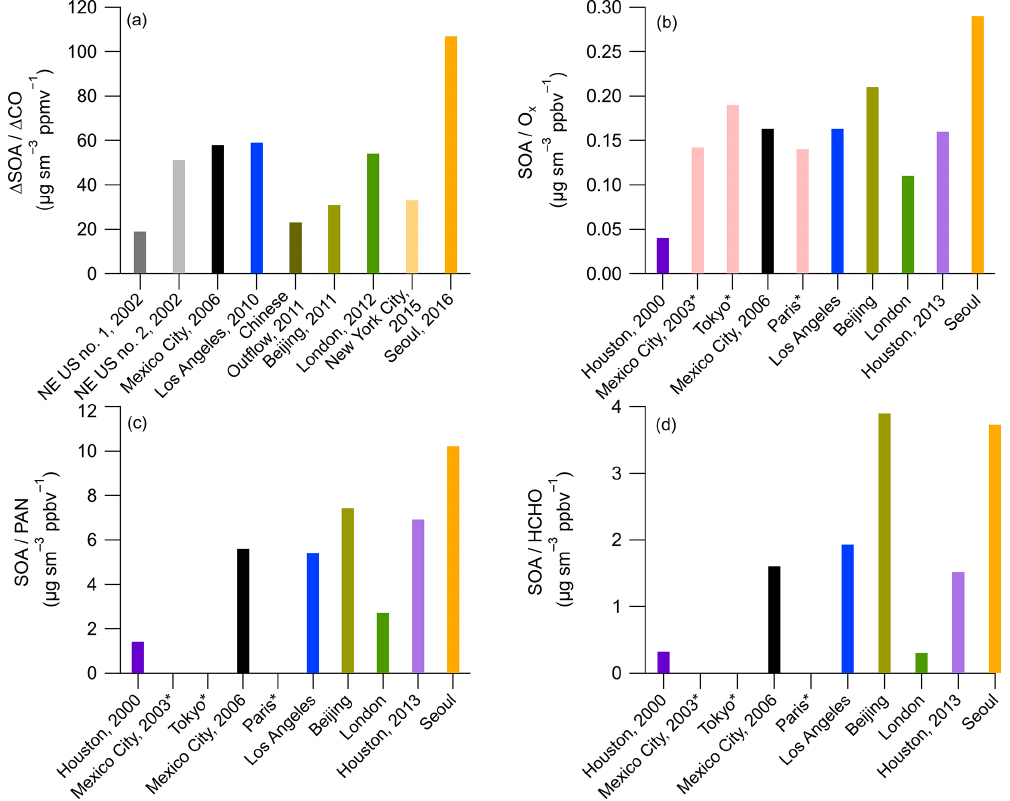
Figure 3. (a) A comparison of the (cid:49) SOA /(cid:49) CO for the urban campaigns on three continents. Comparison of (b) SOA / O x , (c) SOA / HCHO, and (d) SOA / PAN slopes for the urban areas (Table S4). For panels (b) through (d) , cities marked with ∗ have no HCHO, PAN, or hydrocarbon